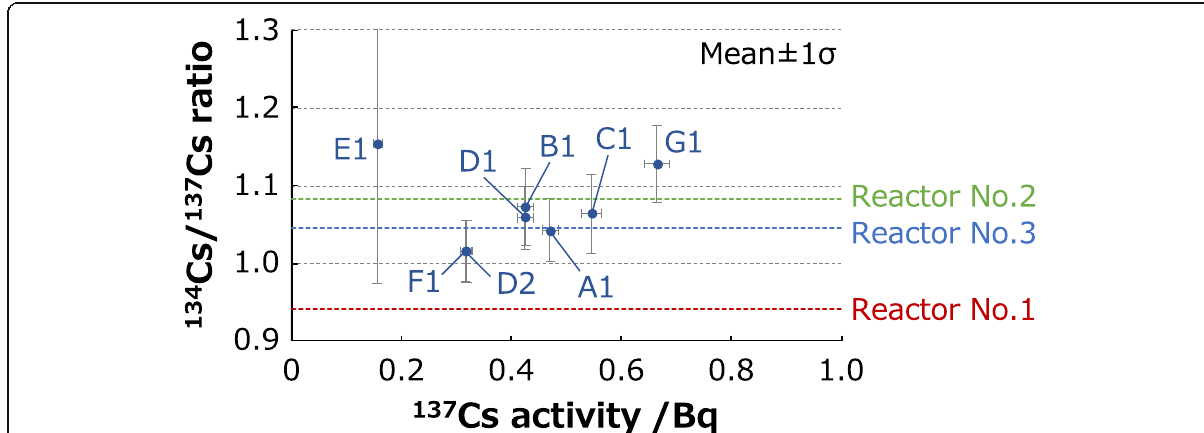
Fig. 2 Radioactivity of 137 Cs and 134 Cs/ 137 Cs activity ratio of individual particles. The radioactivity of 137 Cs (± 1 × standard deviation, σ ) of eight particles (A1~G1) are as follows: 0.471 ± 0.016 Bq (particle A1), 0.426 ± 0.015 Bq (B1), 0.546 ± 0.019 Bq (C1), 0.425 ± 0.014 Bq (D1), 0.318 ± 0.011 Bq (D2), 0.156 ± 0.008 Bq (E1), 0.317 ± 0.011 Bq (F1), and 0.665 ± 0.023 Bq (G1). The three dashed lines show estimates of the 134 Cs/ 137 Cs ratio of nuclear fuel in FDNPP reactors No. 1, 2, and 3, respectively, at the time of the accident, as calculated using ORIGEN2 Code (Nishihara et al. 2010).